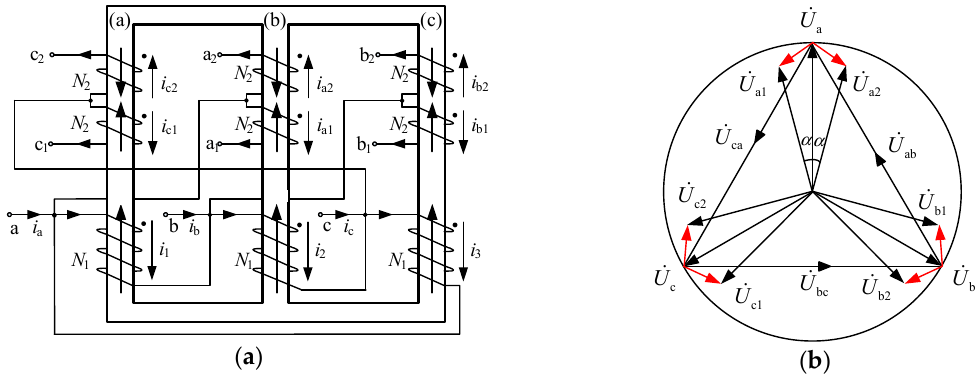
Figure 2. ( a ) Winding configuration of the delta-connected autotransformer; ( b ) Phasor diagram of the delta-connected autotransformer.